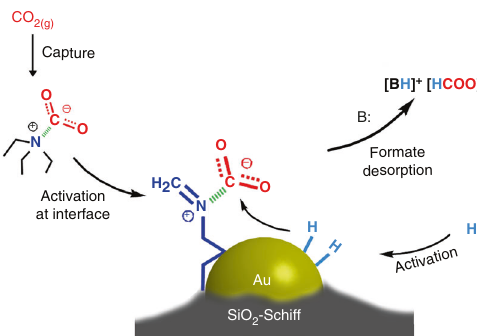
Fig. 5 Proposed synergetic mechanism for the hydrogenation of CO 2 to formate. The activation of CO 2 can be achieved through a weakly bonded